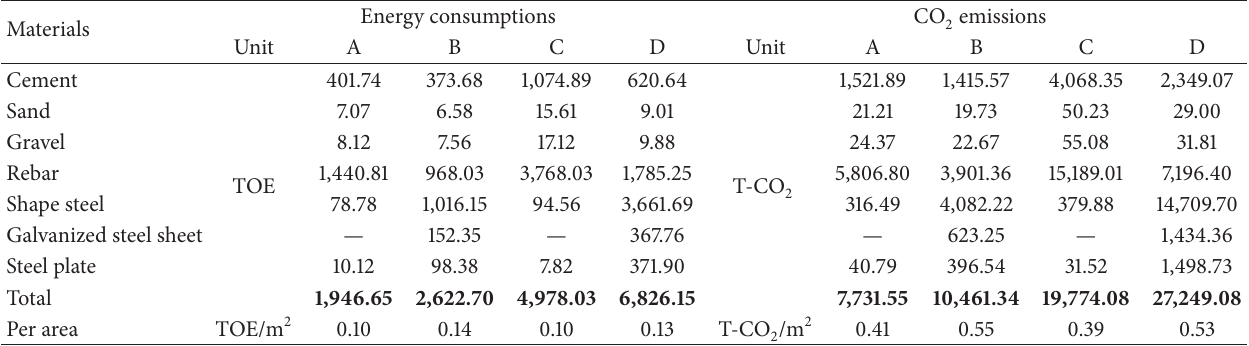
emissions, as per I/O 2